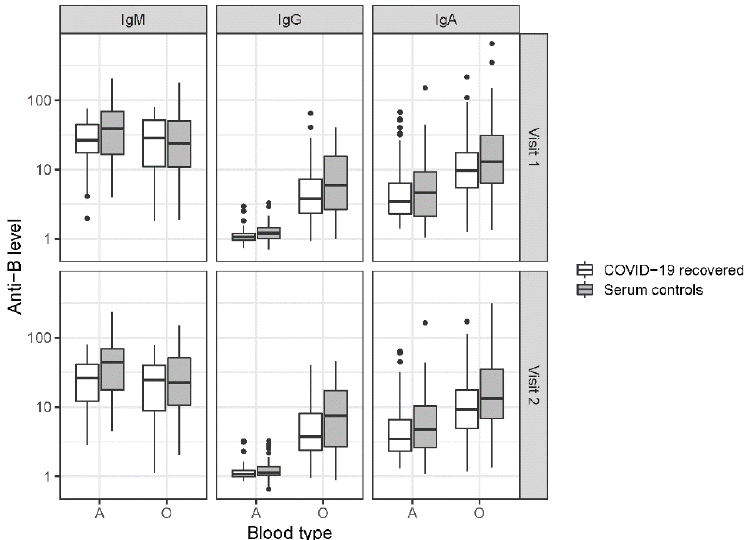
Figure 2. Anti-B levels in the serum of COVID-19 convalescents and controls. ABO Anti-B values of the isotypes IgM, IgG and IgA determined are indicated, each for ABO types A and O. Values are displayed on a log10-scale on the y -axis.